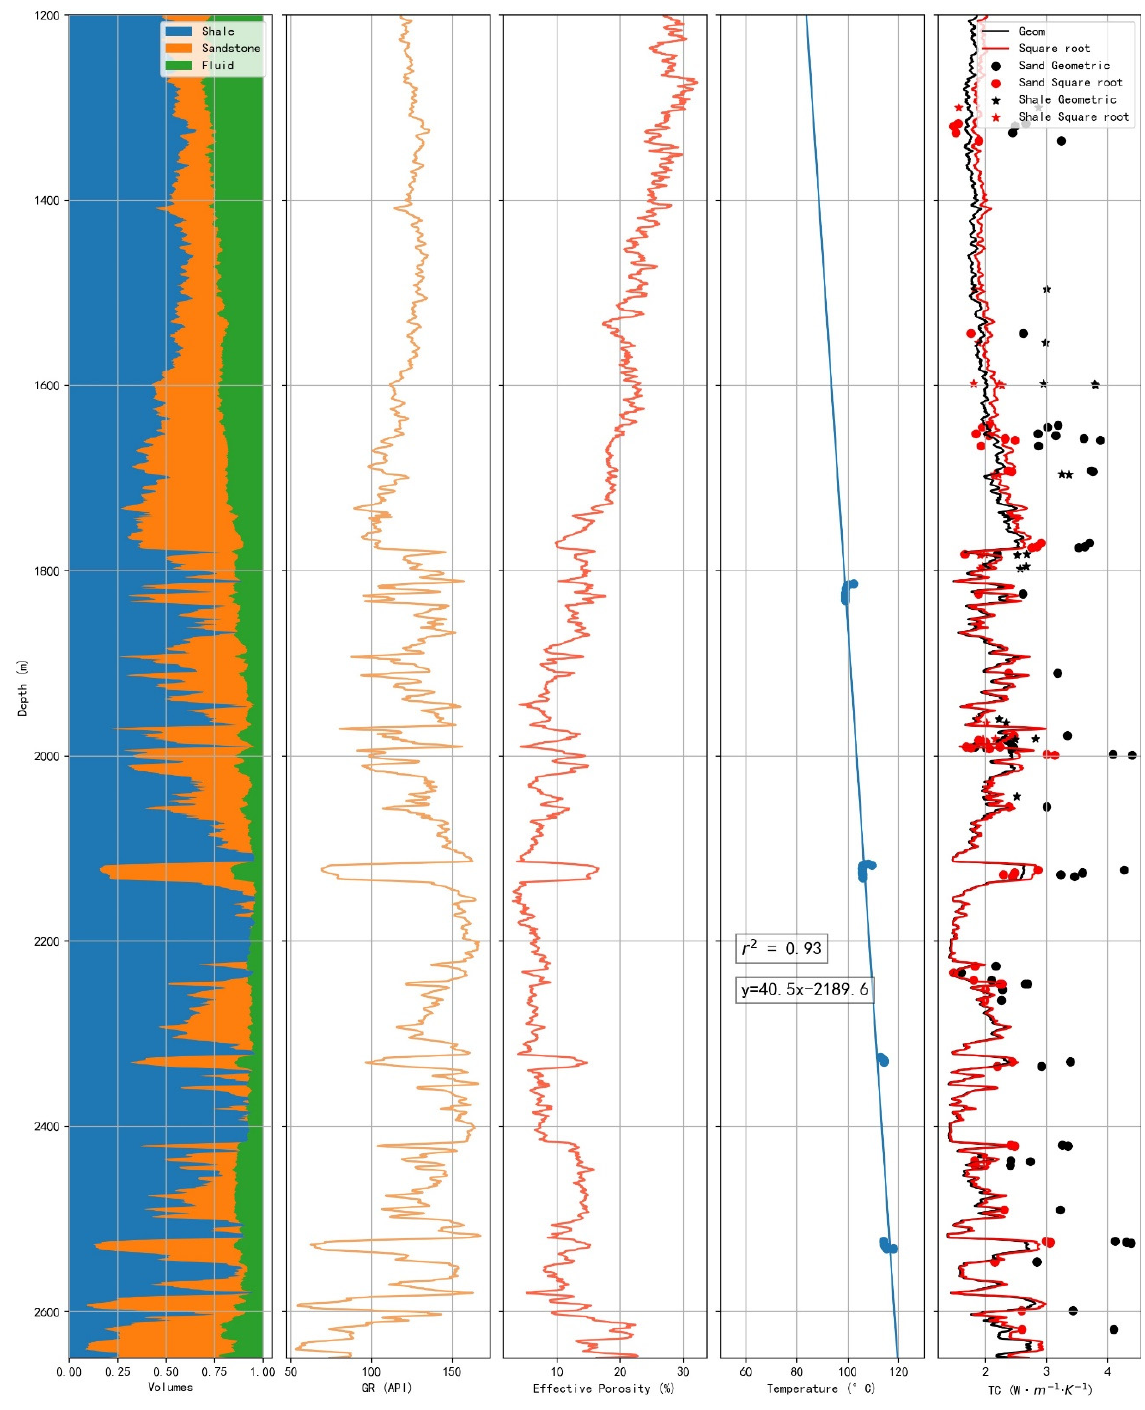
Figure 3. Results of the sand–shale–water model. Input data: GR—natural gamma-ray, effective porosity, and temperature. Output data: the volume model and the predicted TC.